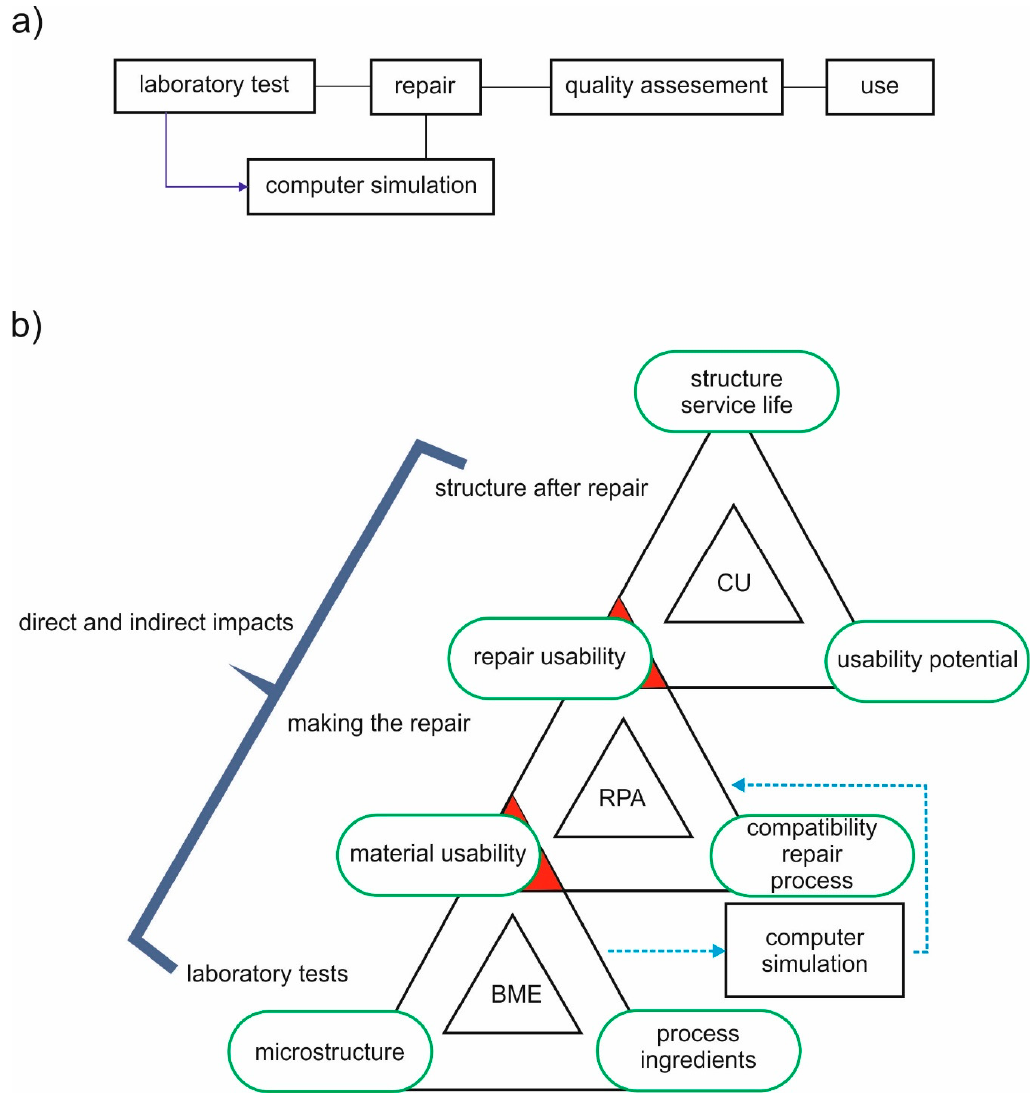
Figure 7. Multi ‐ scale engineering: ( a ) basic operation, ( b ) the repaired structure (based on Mo Li [29]): IMB—Building Materials Engineering; RPA—Repair Performance Assessment; CU—Use of the structure. The repair process operations are carried out taking into consideration direct and indirect impacts, namely both functional and environmental